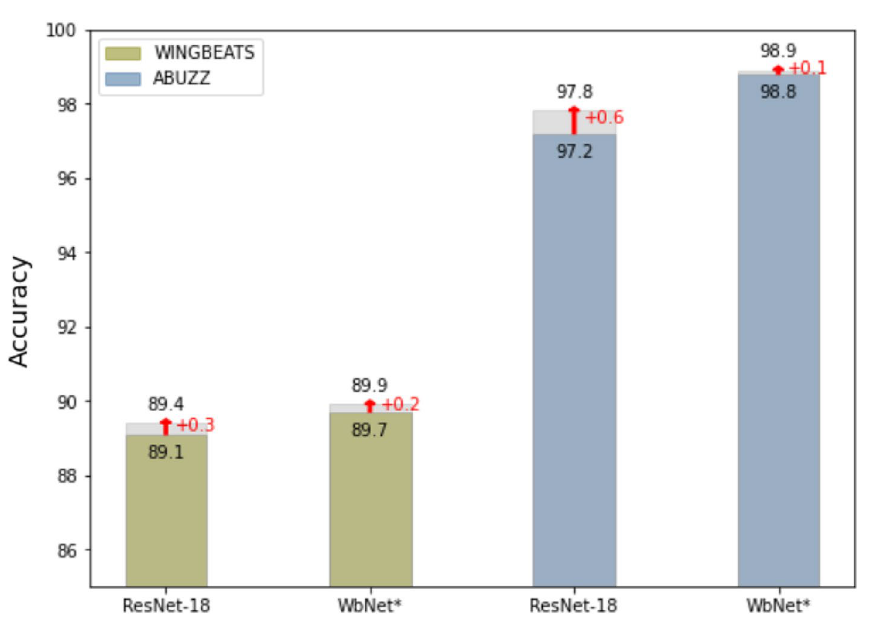
Figure 3. Data augmentation on ResNet-18 and WbNet model, percentage increased shown in